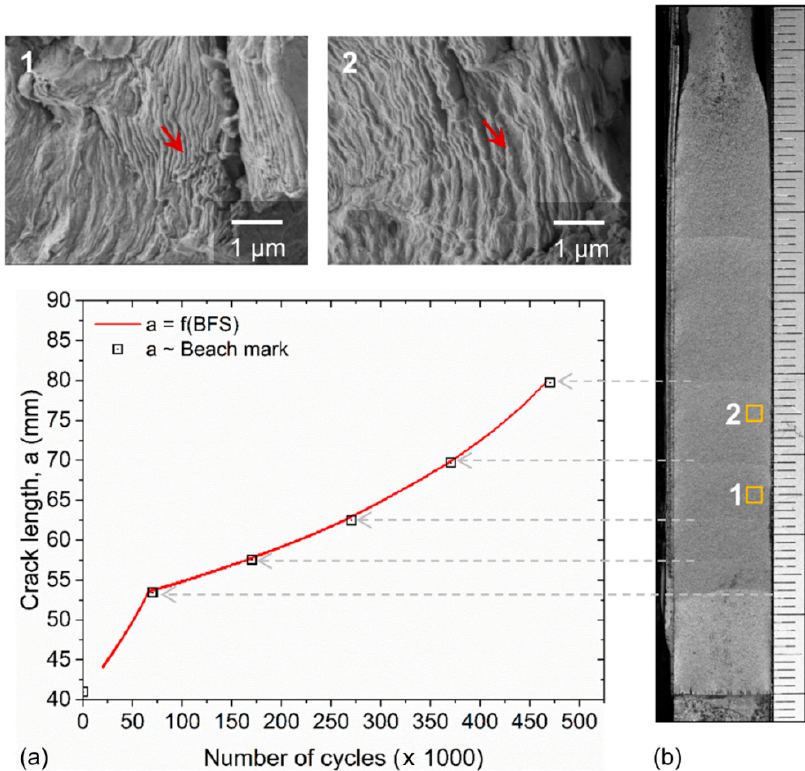
Figure 7. Fractographic approach to validate calculated crack length using BFS data. The figure shows ( a ) a plot of crack length vs. number of load cycles with ( b ) an optical image showing the corresponding beach marks directly observed on the fracture surface. The high-magnification SEM micrographs (insets 1 and 2) show locations 1 and 2 of fatigue striations with different spacings (red arrows in each inset point to an individual striation).